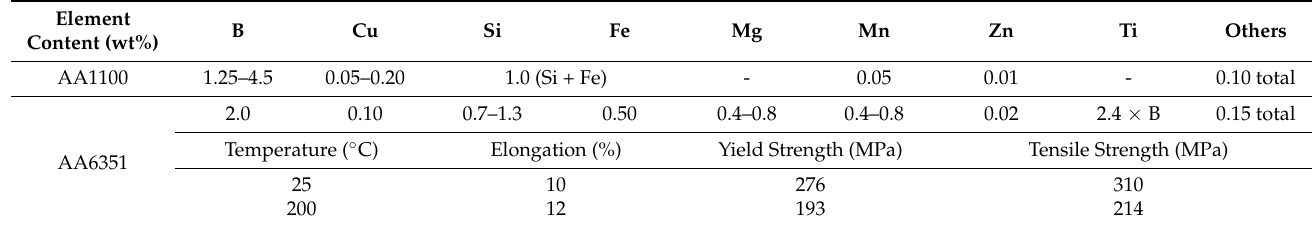
Table 3. Standard composition and mechanical properties of the B/A1 alloy [42].